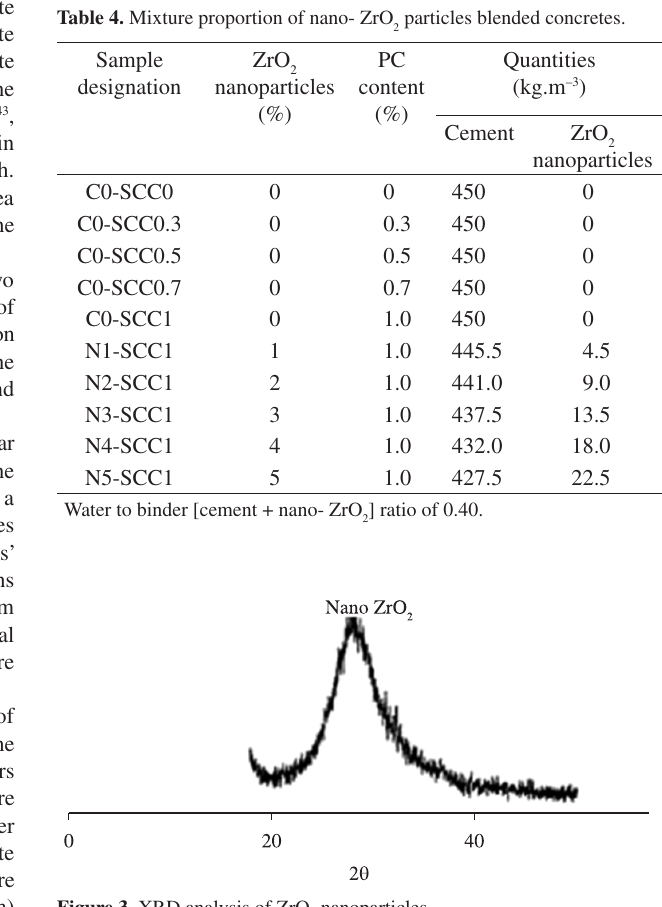
Table 4. Mixture proportion of nano- ZrO